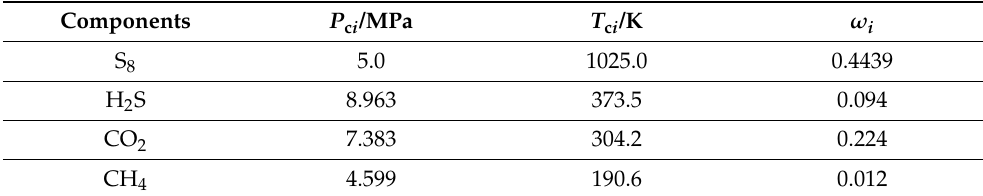
Table 1. Critical parameters for major natural gas